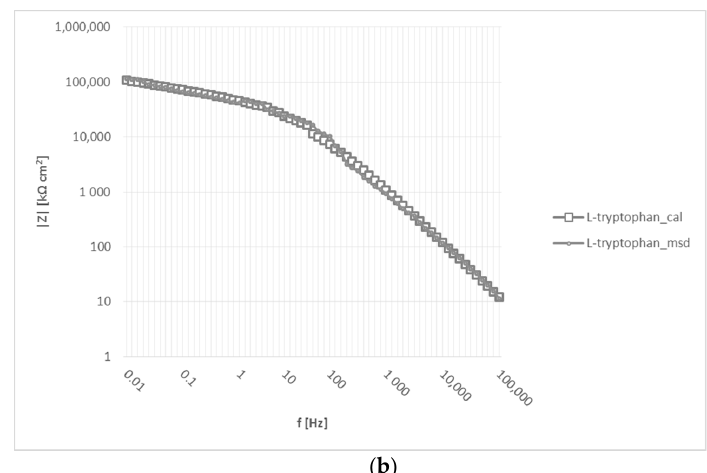
Figure 8. The Nyquist diagram ( a ) and Bode diagram ( b ) of tested L-tryptophan after 24 h immersion in 1% NaCl solution.